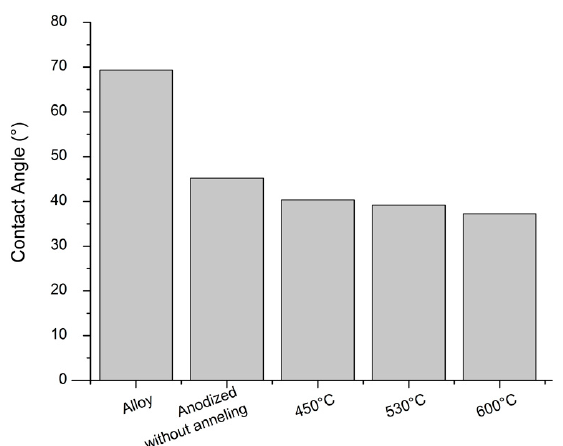
Figure 3. Contact angle of Ti–30Ta alloy before and after nanotubes of TiO2 growth in 0.25% NH 4 F + glycerol at 30 V for 9 h. Group 1—Ti–30Ta alloy without surface modification, Group 2—anodized without annealing, Group 3—450 ◦ C-nanotubes of TiO 2 annealed at 450 ◦ C, Group 4—530 ◦ C-nanotubes of TiO 2 annealed at 530 ◦ C annealed and group 5—600 ◦ C-nanotubes of TiO 2 annealed at 600 ◦